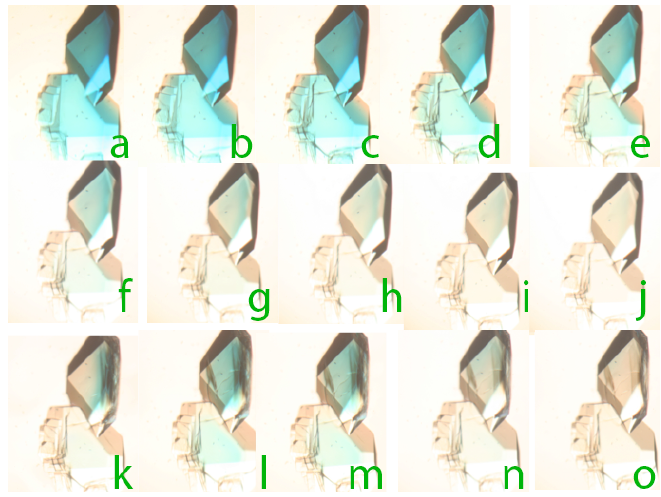
Figure 7. Lysozyme crystals were saturated with the dye methyl green ( a ) and bisulfite added to the mother liquor in ( b ). The green color was progressively lost as the dye was reduced. At ( k ), however, oxygen from the environment competed to re-oxidize the dye, which then experienced a second cycle of reduction in ( n ) and ( o ). The series of images ( a – o ), taken at appropriate time intervals, shows the progress of the dye.